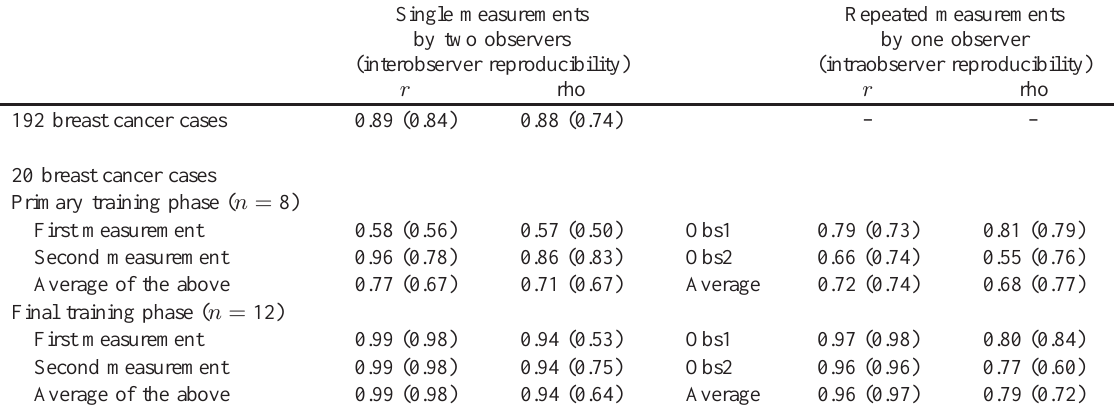
Table 4 Grading efficiency of the morphometrically determined mean nuclear profile area (standard deviation of nuclear profile area in brackets). In the material of 192 breast cancer samples the two observers performed the measurements once. The thresholds for classifying the material into two groups were 35 µ m 2 for mean nuclear profile area and 10 µ m 2 for standard deviation of nuclear profile area. The corresponding thresholds for classifying the material into three groups were 30 µ m